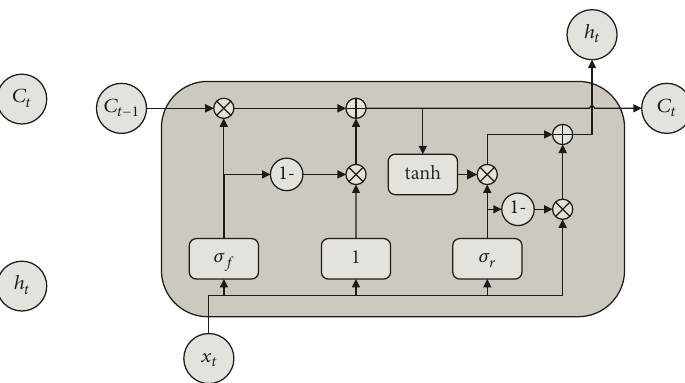
Figure 7: The structure diagram of SRU cell: 휎 𝑓 and 휎 𝑟 are the logistic sigmoid activation function of forget gates and reset gates. 푥 푐 𝑡 and 𝑡−1 mean the inputs of the SRU cell; outputs of the SRU